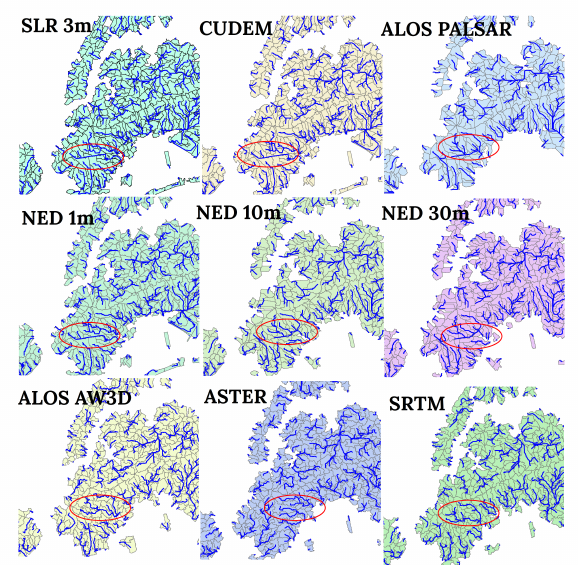
Figure 6. The stream network and watersheds extracted for selected topographical models junction might have caused the stream diversion. While ALOS PALSAR, NED 10, and 30m DEMs represented the identical streamlines and watersheds.